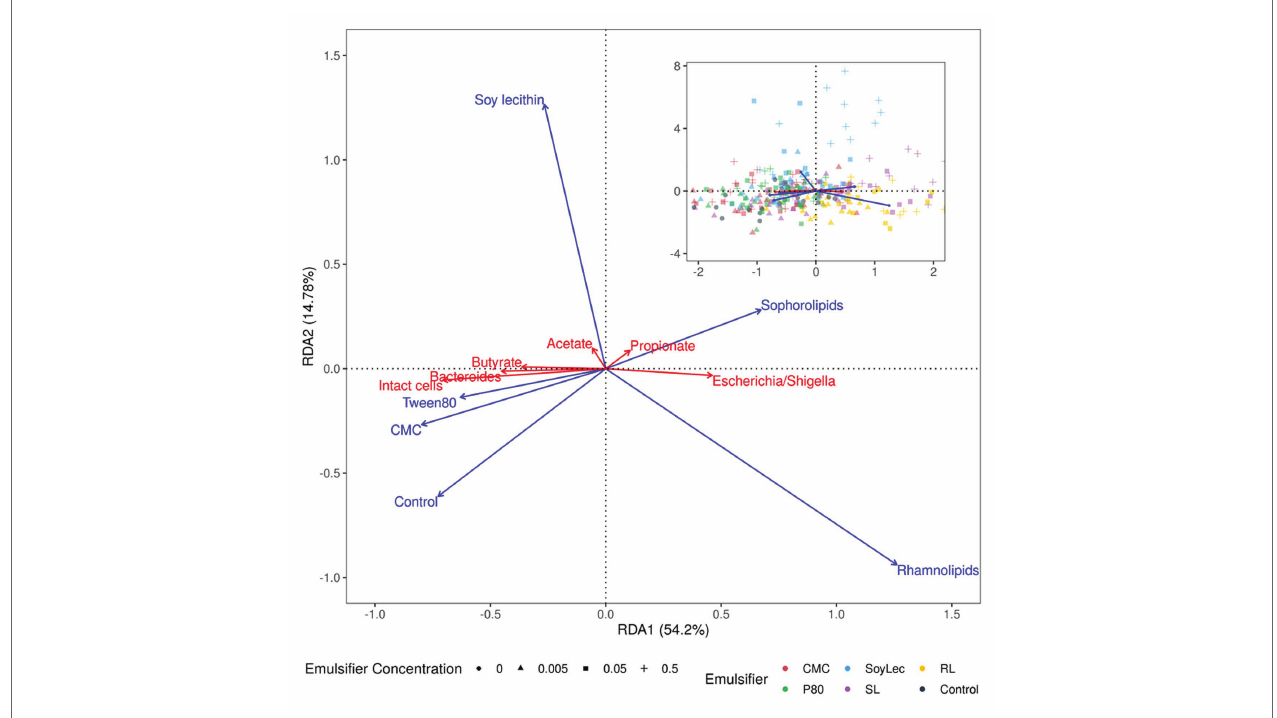
FIGURE 1 | Type II scaling triplot obtained using partial redundancy analysis of the microbial community detected after 48 h of in vitro batch incubations of fecal material from 10 human donors in sugar depleted medium supplemented with five emulsifiers at four concentrations. In the main figure, the intact cell count, the short chain fatty acid (SCFA)-levels, and the relative abundance of the top two genera are shown as response variables (red arrows), and emulsifier concentration are given as explanatory variables (blue arrows). The top right figure also displays the samples as sites. Axes are annotated with their contribution to the total